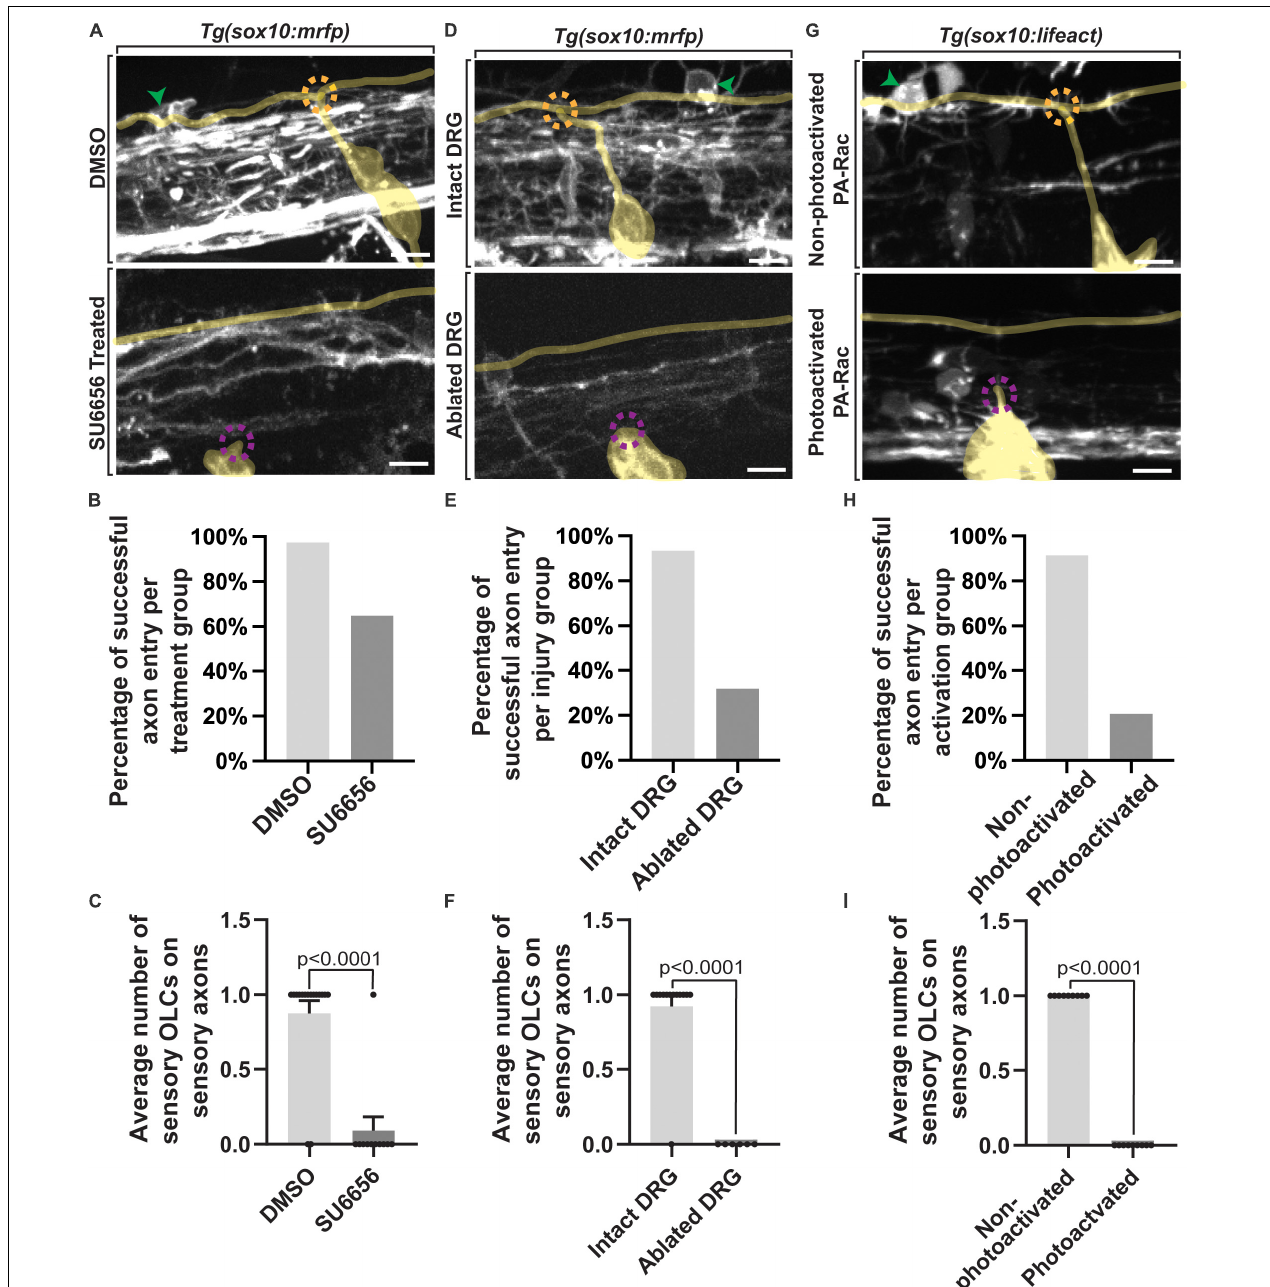
FIGURE 4 | Failed axon entry does not result in sensory-related OLCs. (A) Confocal z-stack images of Tg(sox10:mrfp);Tg(ngn1:gfp) zebrafish at 3 dpf showing axon entry and the presence or absence of a sensory-related OLC in DMSO control animals compared to SU6656 treated animals. (B) Quantification representing the percentage of successful axon entry events per DMSO group versus SU6656 treatments. (C) Quantification of the average number of sensory-related OLCs on sensory axons in DMSO versus SU6656 treated animals ( p < 0.0001). (D) Confocal z-stack images of Tg(sox10:mrfp); Tg(ngn1:gfp) zebrafish at 3 dpf showing axon entry and the presence or absence of a sensory OL in intact animals compared to animals with ablated DRGs. (E) Quantification representing the percentage of successful axon entry events per intact group versus ablated DRGs. (F) Quantification of the average number of sensory OCLs on sensory axons in intact DRGs versus ablated DRGs ( p < 0.0001). (G) Confocal z-stack images of Tg(sox10:gal4; uas:lifeact-gfp) animals injected with PA-Rac1 at 3 dpf showing axon entry and the presence or absence of a sensory-related OLC in non-photoactivated animals compared to photoactivated animals. (H) Quantification representing the percentage of successful axon entry events per non-photoactivated group versus the photoactivated group. (I) Quantification of the average number of sensory-related OLCs on sensory axons in non-photoactivated versus photoactivated animals ( p < 0.0001). All green arrowheads represent sensory-related OLCs. All dashed orange circles represent successful axon entry. All dashed magenta circles represent failed axon entry. Yellow tracing overlays highlight the DRG and sensory axons (A,D,G) . Scale bar equals 10 µ m (A,D,G) . All images are orientated anterior to left, posterior to right, dorsal up and ventral down.